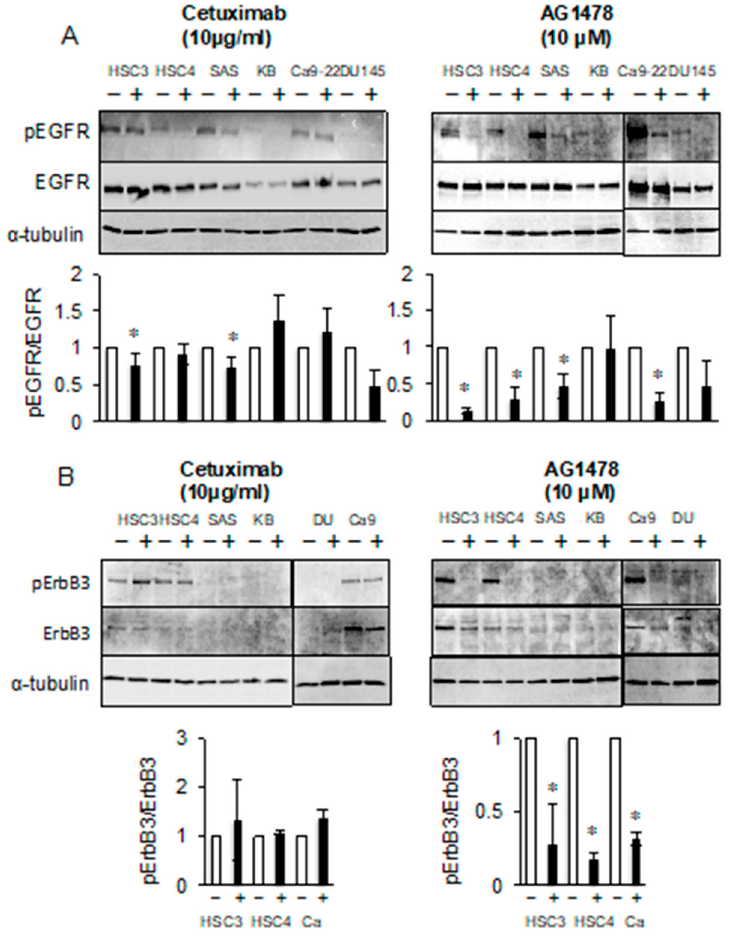
Figure 2. AG1478 and cetuximab have di ff erent inhibitory e ff ects on ErbB signaling of cancer cells. The HSC3, HSC4, Ca9-22, SAS, KB, and DU145 cells were treated with 10 µ g / mL of cetuximab or 10 µ M of AG1478 and the phosphorylation and protein levels of ( A ) epidermal growth factor receptor (EGFR) and ( B ) ErbB3 were determined by western blotting analysis. α -tubulin was used as the loading control. * Significantly di ff erent from control, p < 0.05. Experiments were performed three times independently.